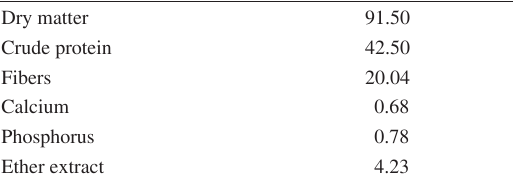
Table 1. Chemical composition of the castor oil cake (%).